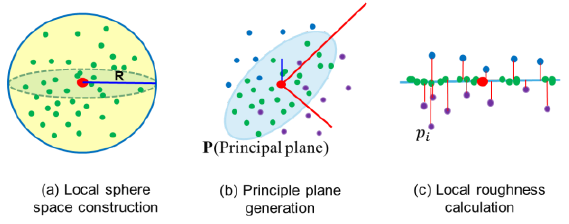
Figure 3. Schematic diagram of the construction of the local